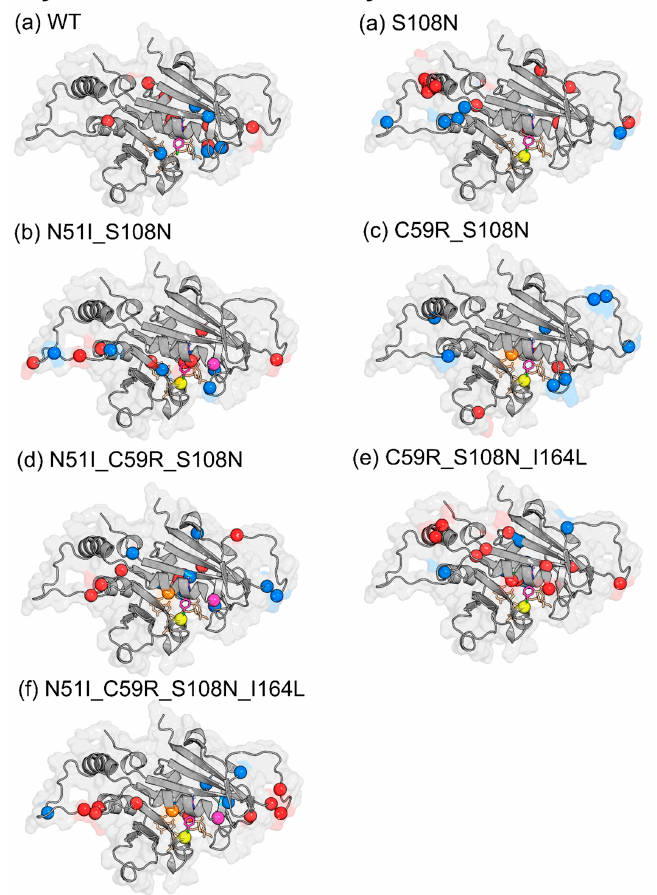
Figure 9. Effects of pyrimethamine binding on intra-protein communication: Structural mapping of residues showing significant changes in average BC. Changes in residue centrality ( Δ BC ) values were obtained by calculating pyrimethamine-free less pyrimethamine-bound average BC values. Residues with significant changes in BC were obtained by using a cutoff value of +/ − 2 SD of Δ BC values for each system. Red spheres represent residues with positive Δ BC values, while blue spheres are residues with negative Δ BC values. Also shown in spheres are pyrimethamine-resistant point mutations investigated in this study: Figure 8 coloring scheme was implemented here as well.